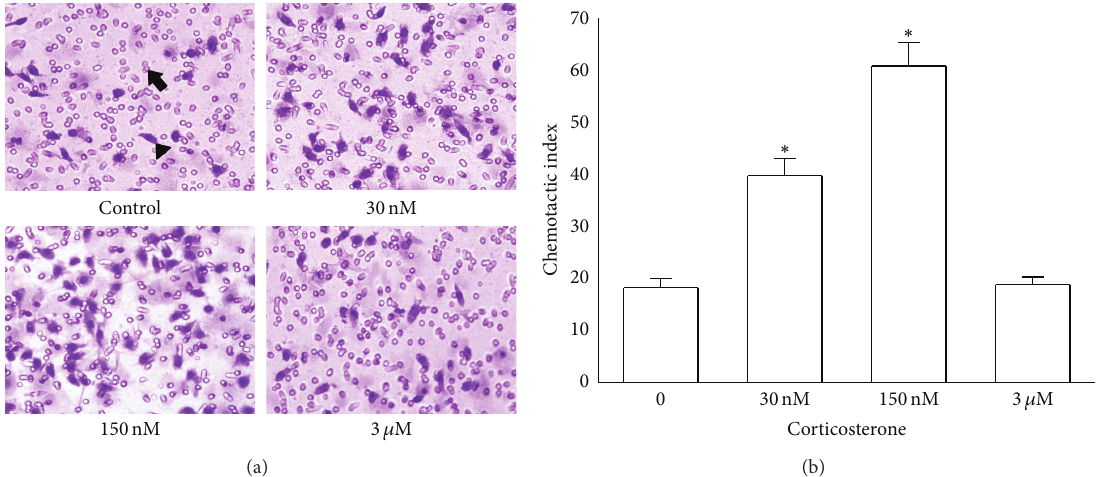
Figure 1: Effects of corticosterone on the chemotaxis of rat peritoneal macrophages. The upper and lower chambers were separated by a 5 𝜇 m pore-sized (arrow) polycarbonate membrane filter (polyvinylpyrrolidone-free). FMLP (10nM) was added into the lower wells to induce cell migration. The filled chamber was incubated at 37 ∘ C for 3 h and then the cells that had not migrated into the lower chamber were scraped off. The filter was fixed with 4% paraformaldehyde for 20 min and the cells were stained with hematoxylin-eosin. The migrated cells (arrowhead) were counted under microscopy ( × 400). (a) Rat peritoneal macrophages were treated with vehicle diluent (ethanol) as control. Macrophages were treated with 30nM, 150 nM, and 3 𝜇 M corticosterone, respectively. (b) The results were representative of five independent experiments performed on triplicate samples. ∗ 𝑃 < 0.01 versus the control